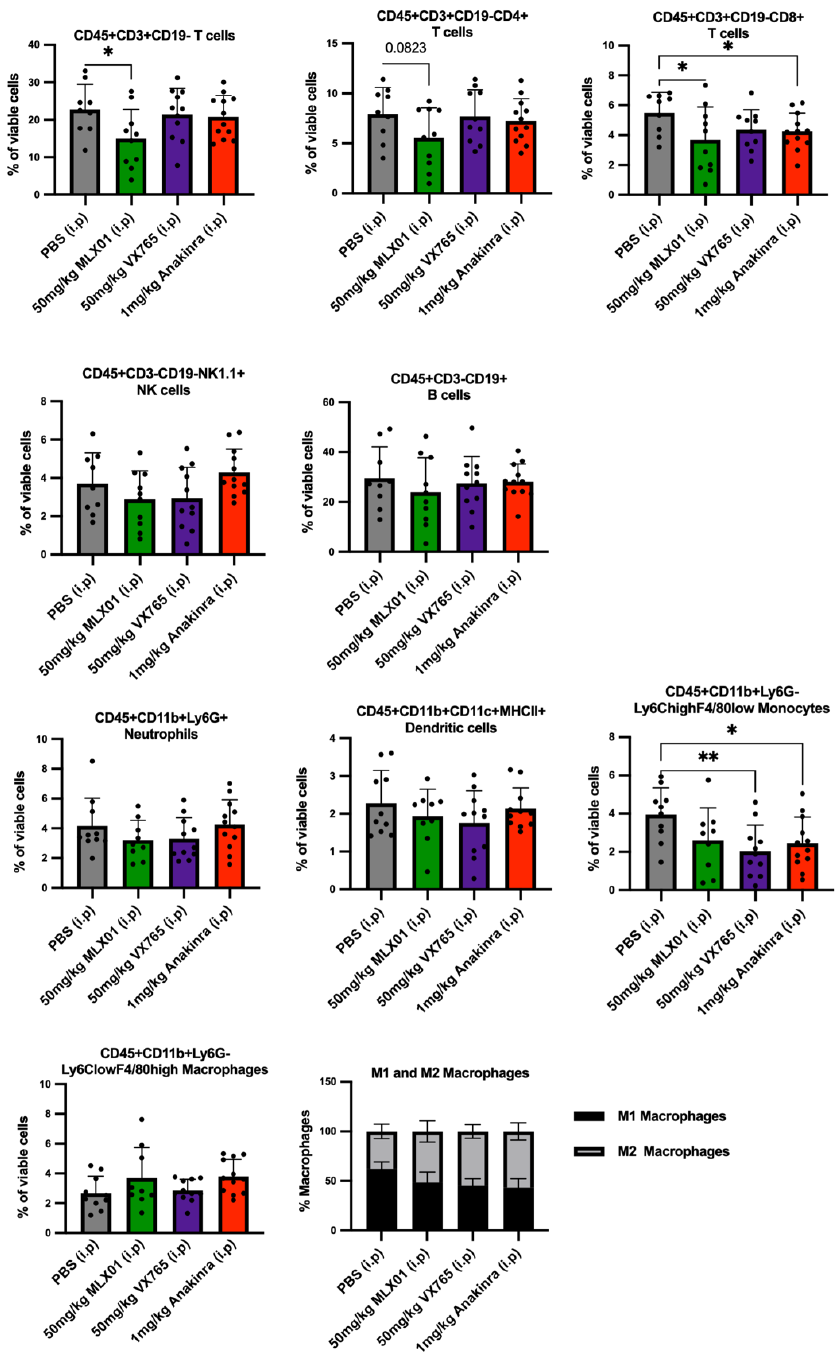
Figure 6. Effects of MLX01, VX765 and Anakinra on systemic immune cell populations . Immune